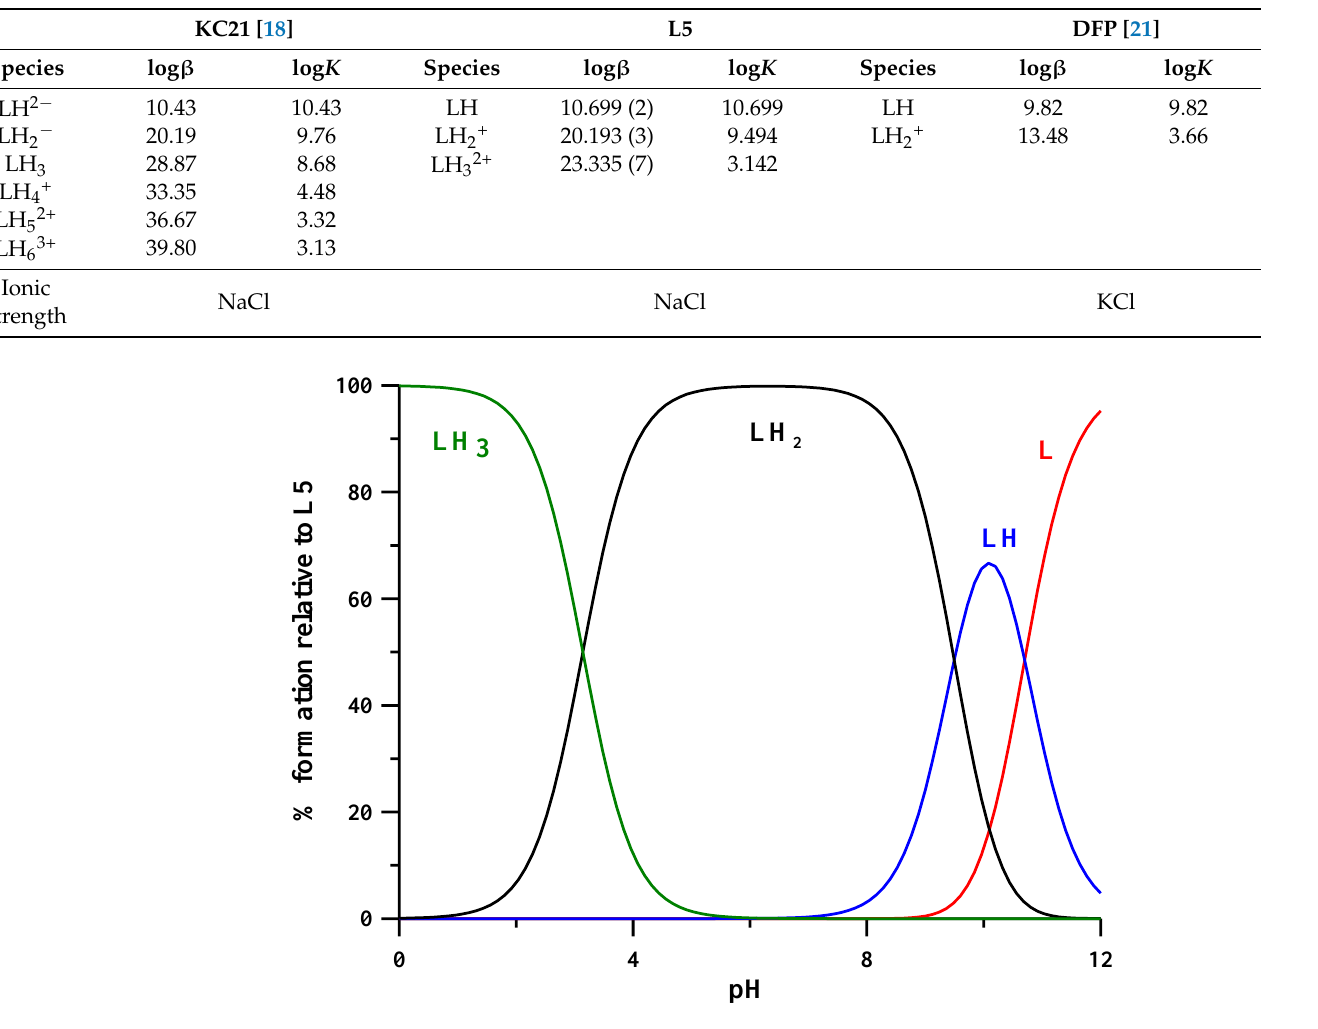
Figure 2. Speciation plot of L5 ligand calculated with HySS [22] according to the protonation constants in Table 1.